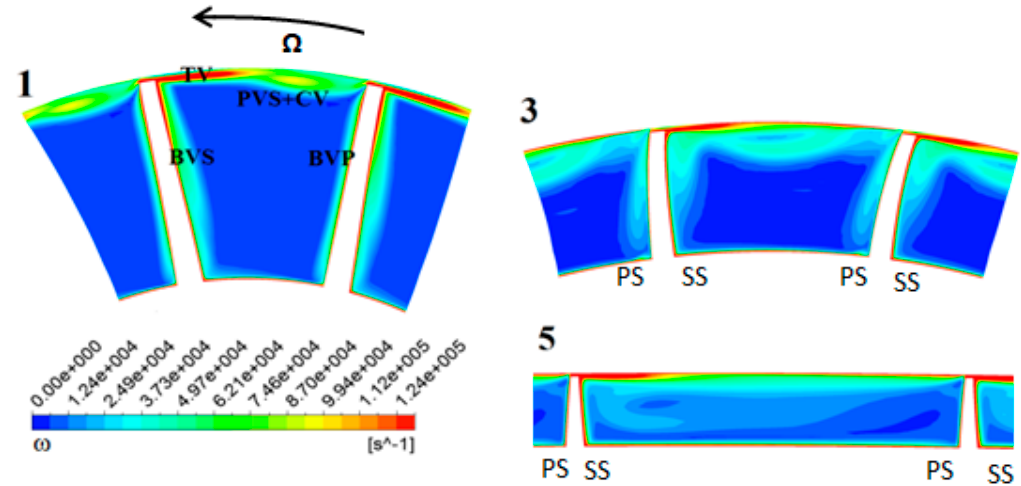
Figure 11. Vorticity in three hub-to-shroud surfaces of the impeller, point P1. PVS—passage vortex at